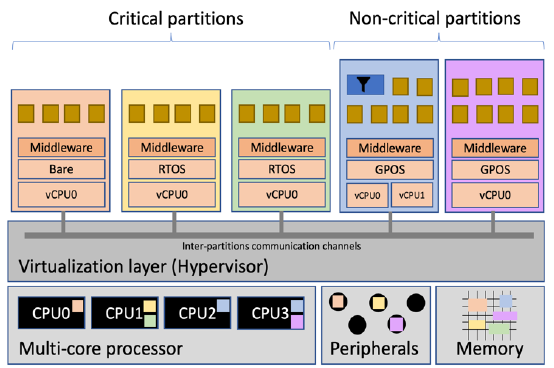
Figure 3. Overview of an embedded I4.0 component in a mixed-criticality context.